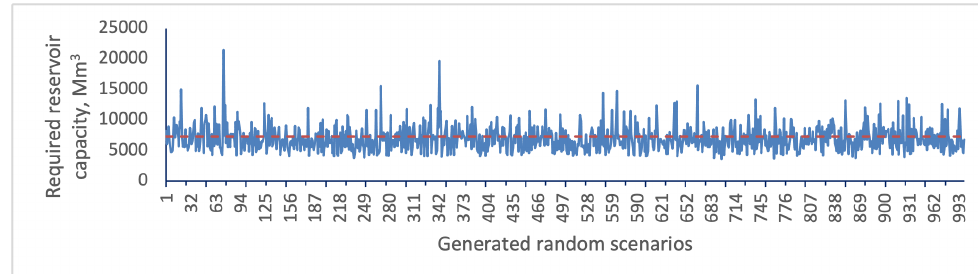
Figure 12. Reservoir capacity uncertainty using the generated random inflow